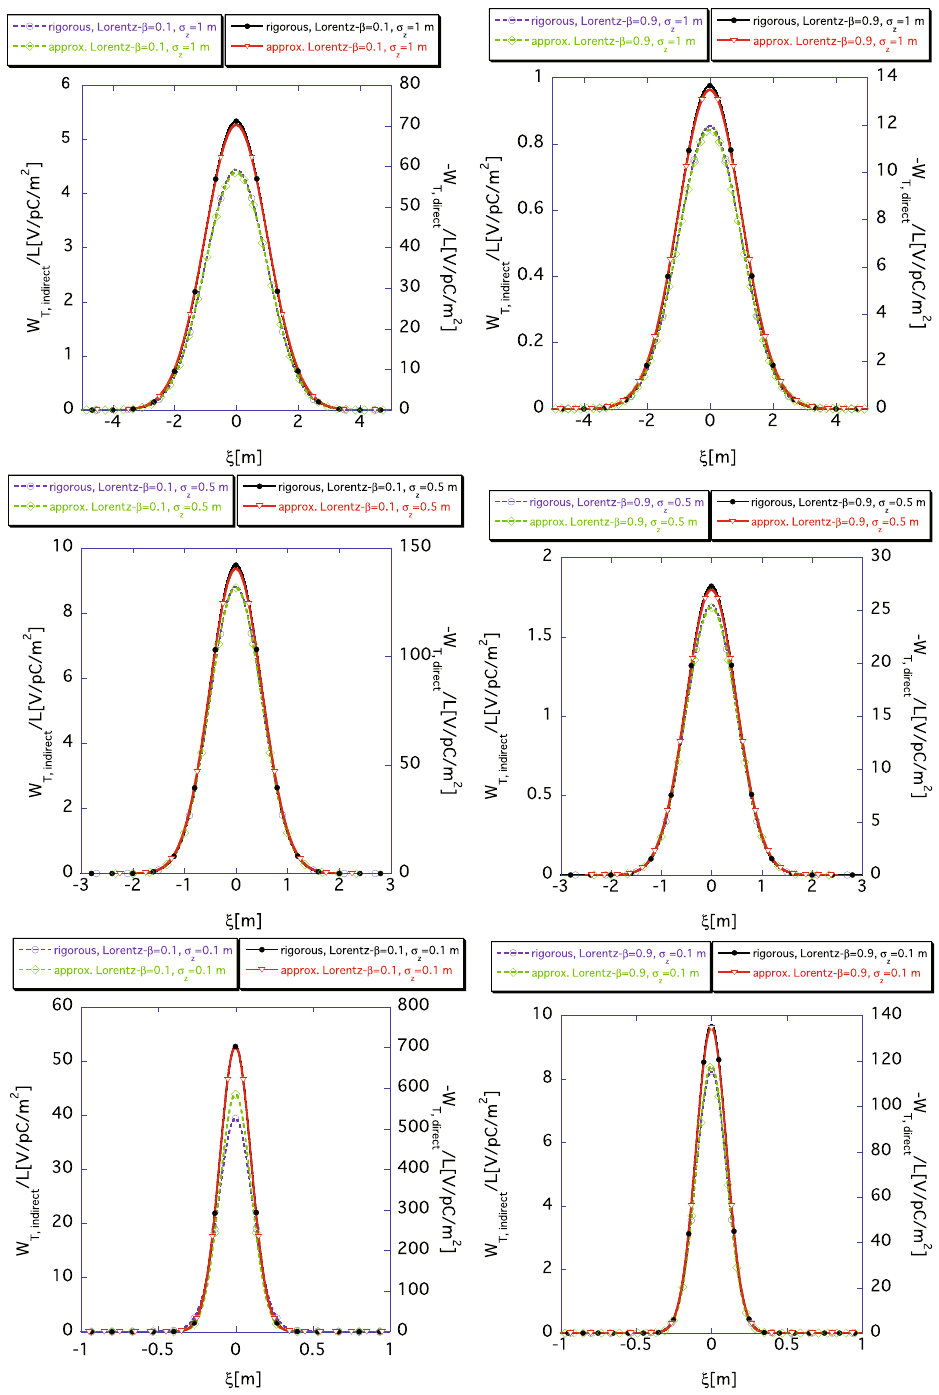
Figure 10. The rms bunch length σ z dependence of W T , indirect ( ξ ) according to Eq. (75) and W T , direct ( ξ ) according to Eq. (74) for fixed segment size 2 Δ z = 2 σ z /5, where r b = 10 mm and a = 40 mm. The upper, middle and lower panels show the wake functions for σ z = 1 m, for σ z = 0.5 m, and for σ z = 0.1 m, respectively. The left and right panels show the wake functions for β = 0.1, and for β = 0.9, respectively. The dashed (read using the scale markings on the left axis) and solid lines (read using the scale markings on the right axis) show the indirect W T , indirect ( ξ ) and the direct W T , direct ( ξ ) space-charge wake functions, respectively. The black and purple lines show the exact wake functions obtained according to Eqs (24) and (25), respectively. The red and green lines show the approximate wake functions obtained using Eqs (74) and (75),